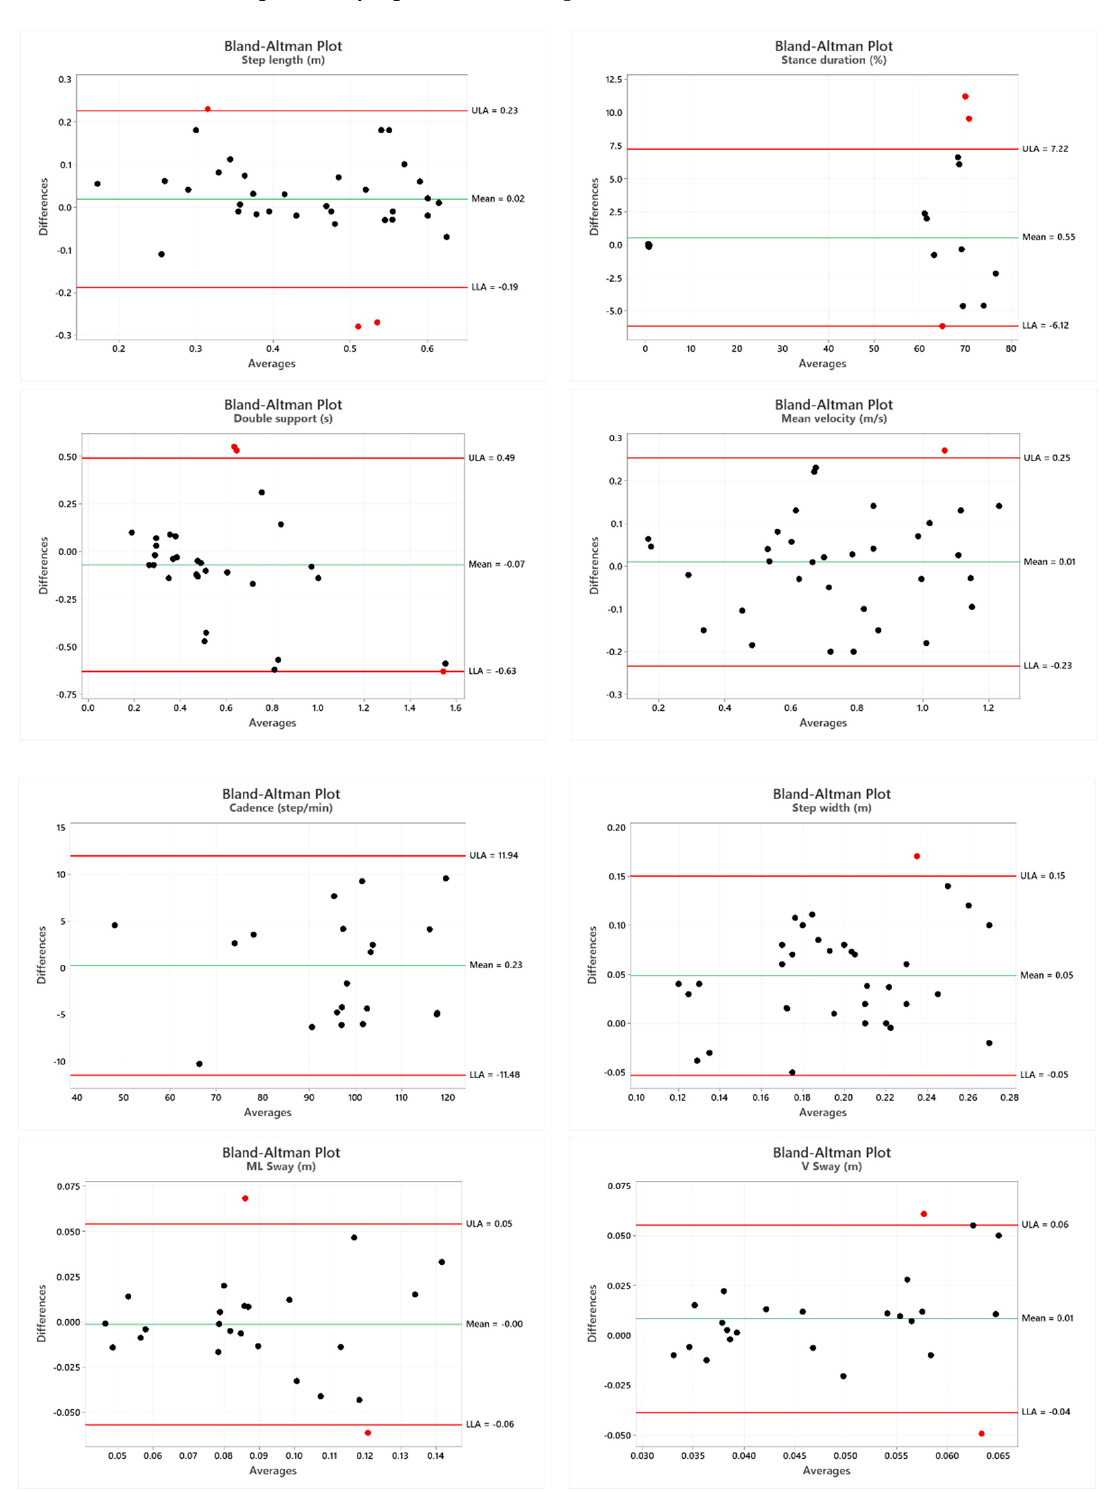
Figure 3. Bland–Altman plots of the mean of 3D-GA and the RGB-D systems against the difference between the two methods for the spatio-temporal parameters and the COM Sway.